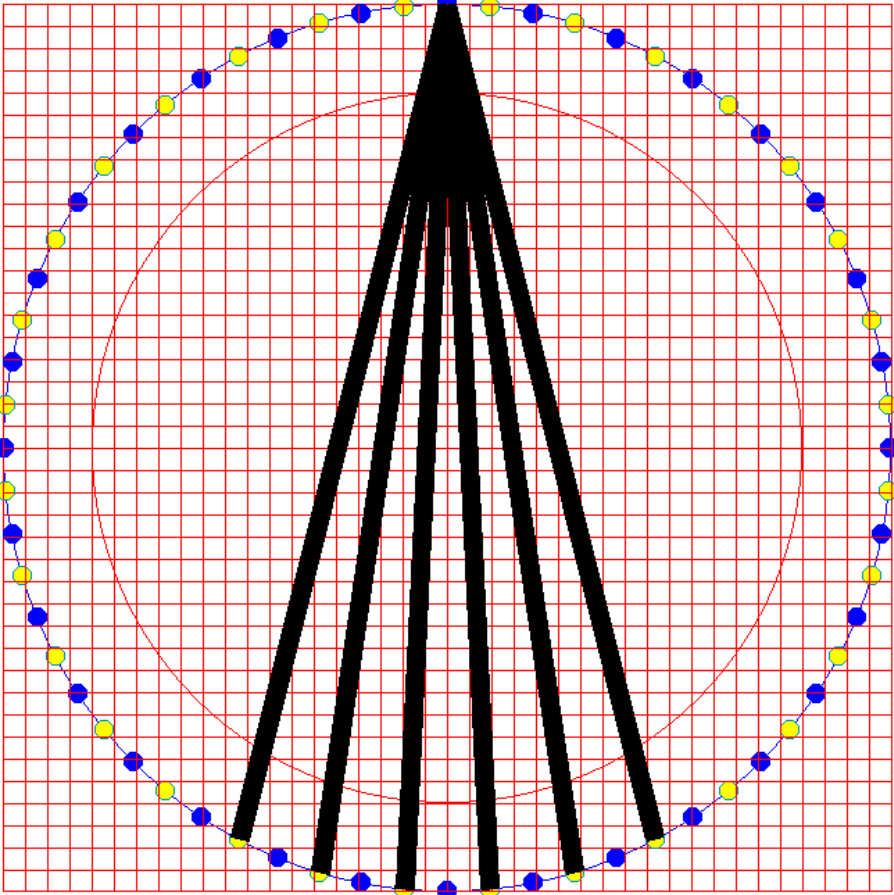
Figure 2. Single transmitter light